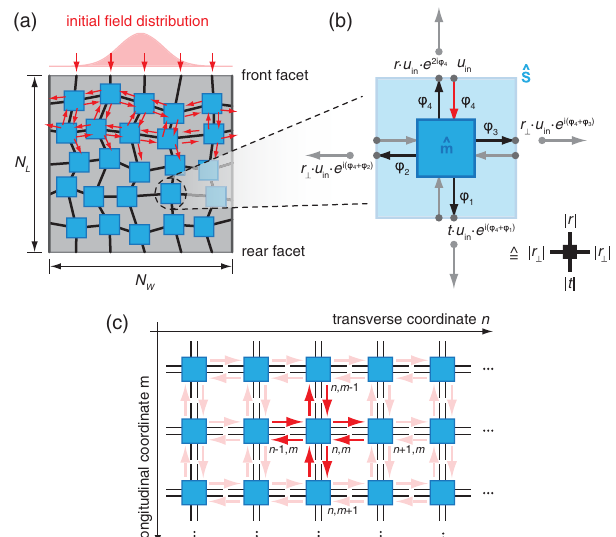
FIG. 5. Numerical model. (a) Approximation of the sample as a network of scatterers. The initial field distribution is continuously fed to the first row as the field components propagate further and further through the network with every simulation step (see red arrows) until a steady state is reached. (b) One building block, i.e., a single scattering event, is implemented by a stray matrix ˆ m composed of the complex valued scattering amplitudes in the forward ( t ), backward ( r ), and transverse ( r ⊥ ) directions. Illus- trated is the effect on a discrete field component u entering from in the top. The scattered components are multiplied with a phase factor φ p (with p ¼ 1 , 2, 3, 4) to account for the propagation between scattering sites. To simulate wave propagation in a randomly perturbed waveguide, these phases are picked from a Gaussian distribution with mean value kl . The effect of scat scattering and intermediate propagation is combined in the matrix ˆ S . The pictogram on the bottom right illustrates the short notion utilized in the other figures. (c) The transverse coordinate is denoted with n (with 1 ≤ n ≤ N W ) and the longitudinal coor- dinate is denoted with m (with 1 ≤ m ≤ N L